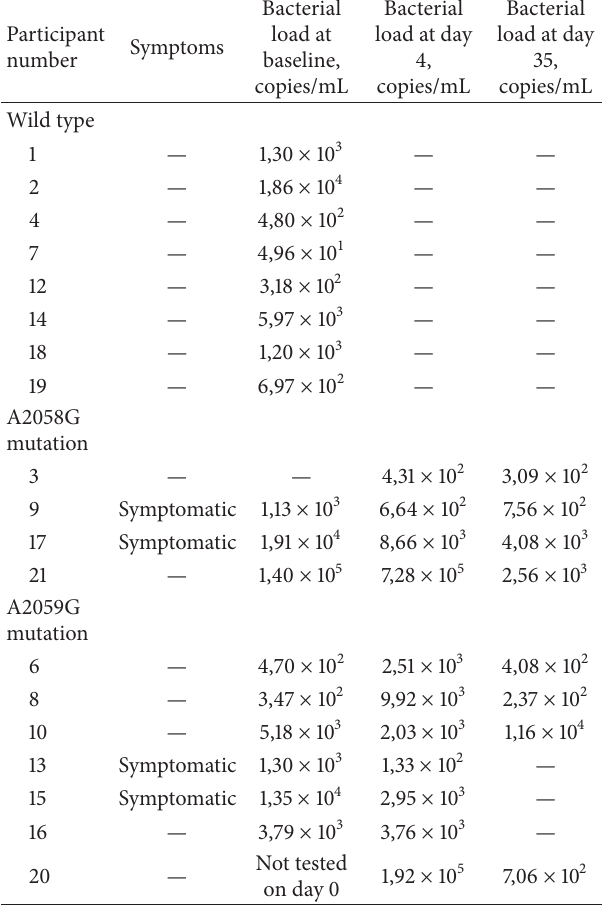
Table 1: Patient number, symptoms, bacterial type, and bacterial load at baseline and on day 4 after treatment with azithromycin 1,5 g. Patients 5 and 11 were excluded from the study. Patient 3 had a negative pretreatment sample but had a titer of 2,36 × 10 2 copies/mL on day 1. Patient 20 was unable to provide a pretreatment sample due to recent micturition and had a titer of 4,01 × 10 5 copies/mL on day 1. Patients 13 and 15 had a negative test at day 35 but tested positive at their follow-up appointment a few days later.